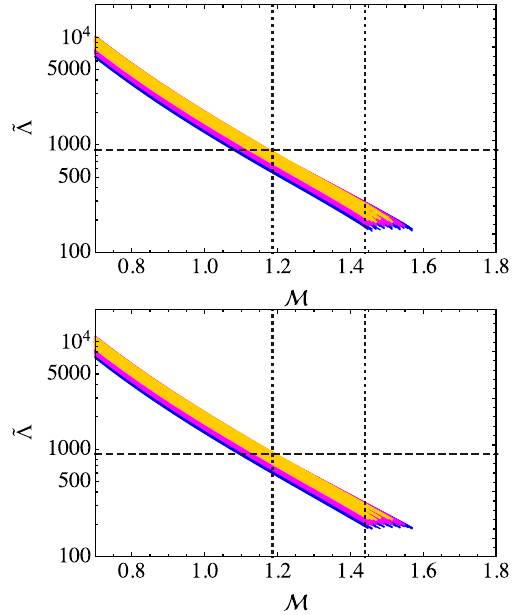
Fig. 8 Combinedtidaldeformability ˜ (cid:2) asafunctionofchirpmass,cal- culated by the astrophysically compatible EOSs for the case of η = 0 . 7 (Upper) and η = 1 . 0 (Lower), respectively. The black-dashed horizon- tal line stands for ˜ (cid:2) = 900, while the two black-dotted vertical lines stand for M = 1 . 186 and M = 1 . 44, respectively